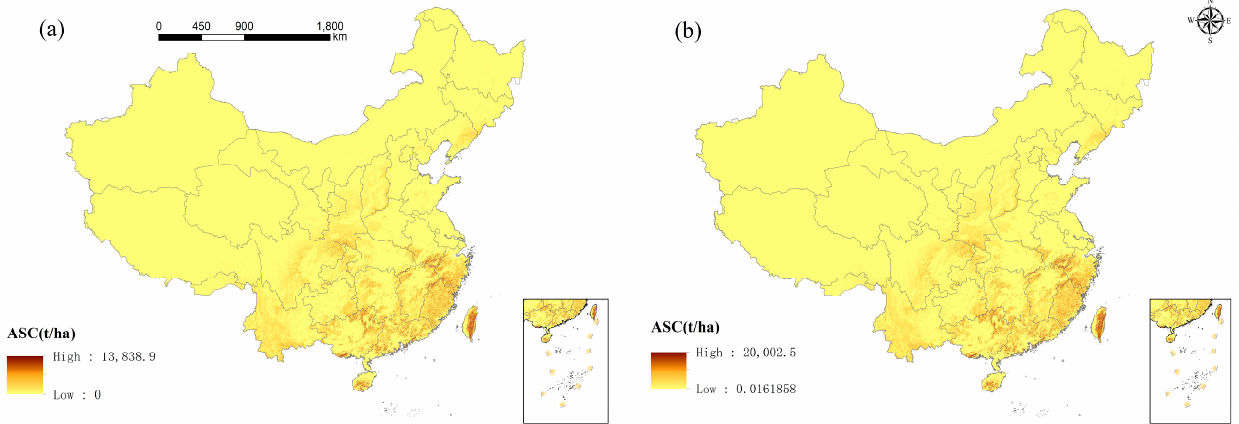
Figure 4. Temporal and spatial evolution of soil conservation function in China. ( a ) Soil and water conservation in 2005 ; ( b ) Soil and water conservation in 2020.